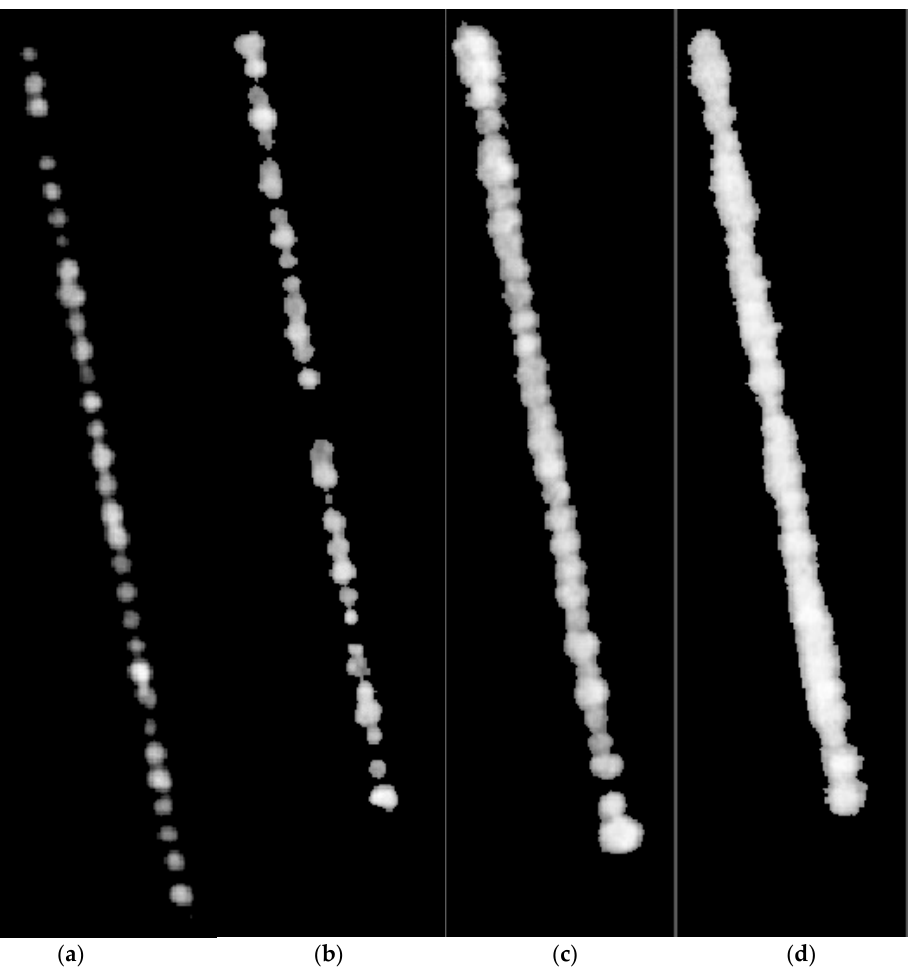
Figure 6. ( a – d ) Background corrected images obtained from applying Otsu thresholding on images shown in Figure 5a–d, respectively. Grey pixels represent normalized difference vegetation index (NDVI) intensity and black pixels represent the background.